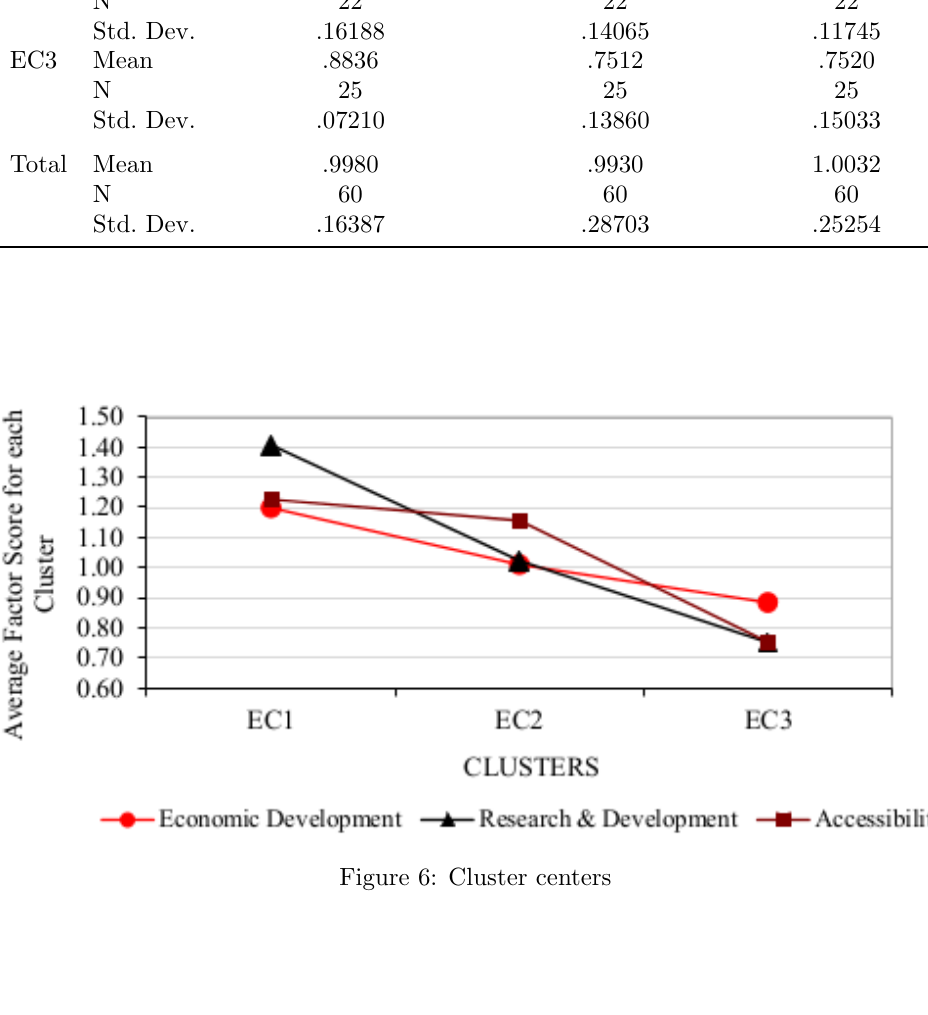
Table 7: Regions per country. Clustering based on the regions’ economic characteristics